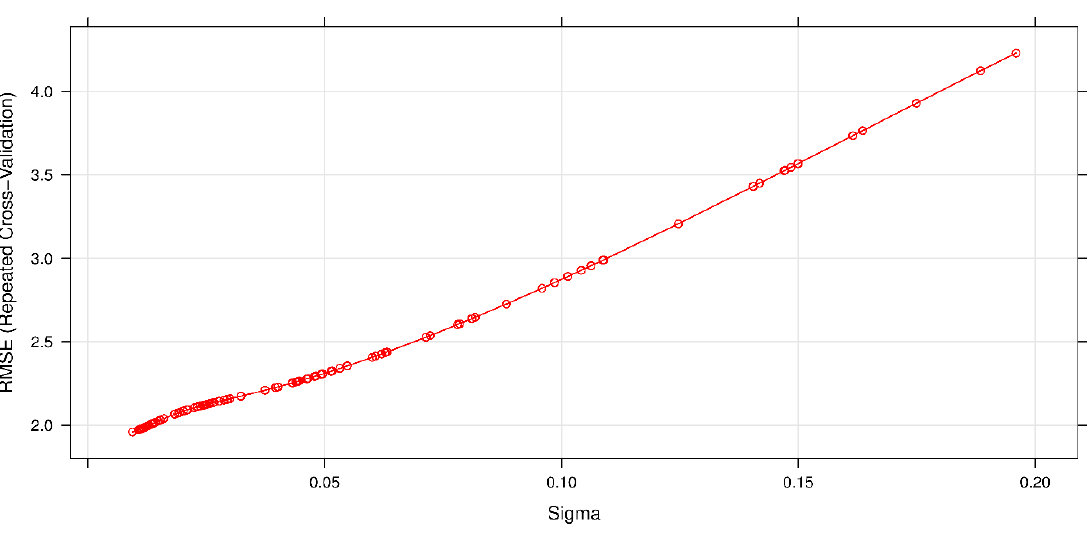
Figure 10. The development process of the classification and regression trees (CART) model for estimating HL.